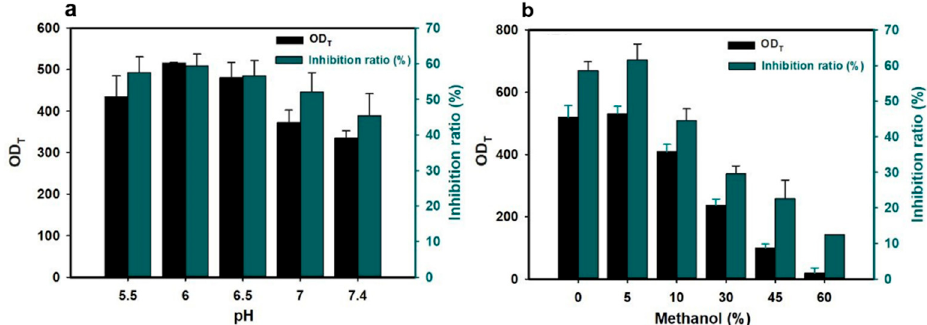
Figure 3. Effect of the pH value ( a ) and methanol concentration ( b ) in the reaction system on the OD T value using the blank corn extraction solution and the competitive inhibition rate using the FB 1 -spiked corn extraction solution (20 ng/mL). The competitive inhibition rate was defined as (1 − B/B 0 ) × 100%, where B 0 and B represent the OD T /OD C value of the FB 1 -negative and positive sample, respectively.